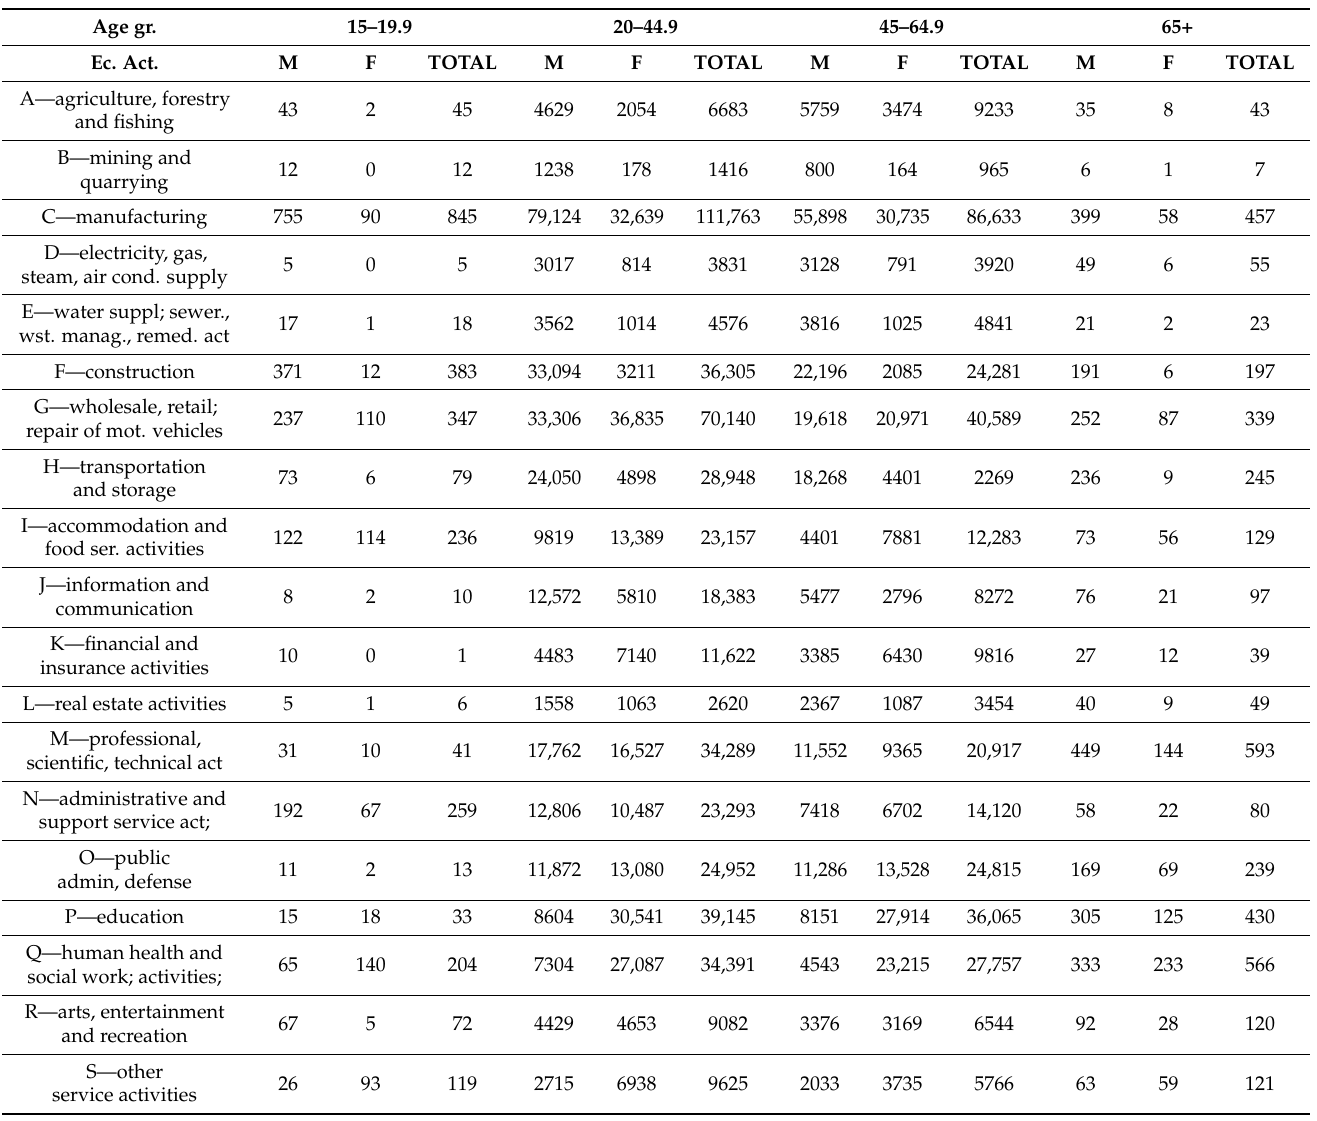
Table 2. The average size of the study population by age, gender and economic activities from 2015 to